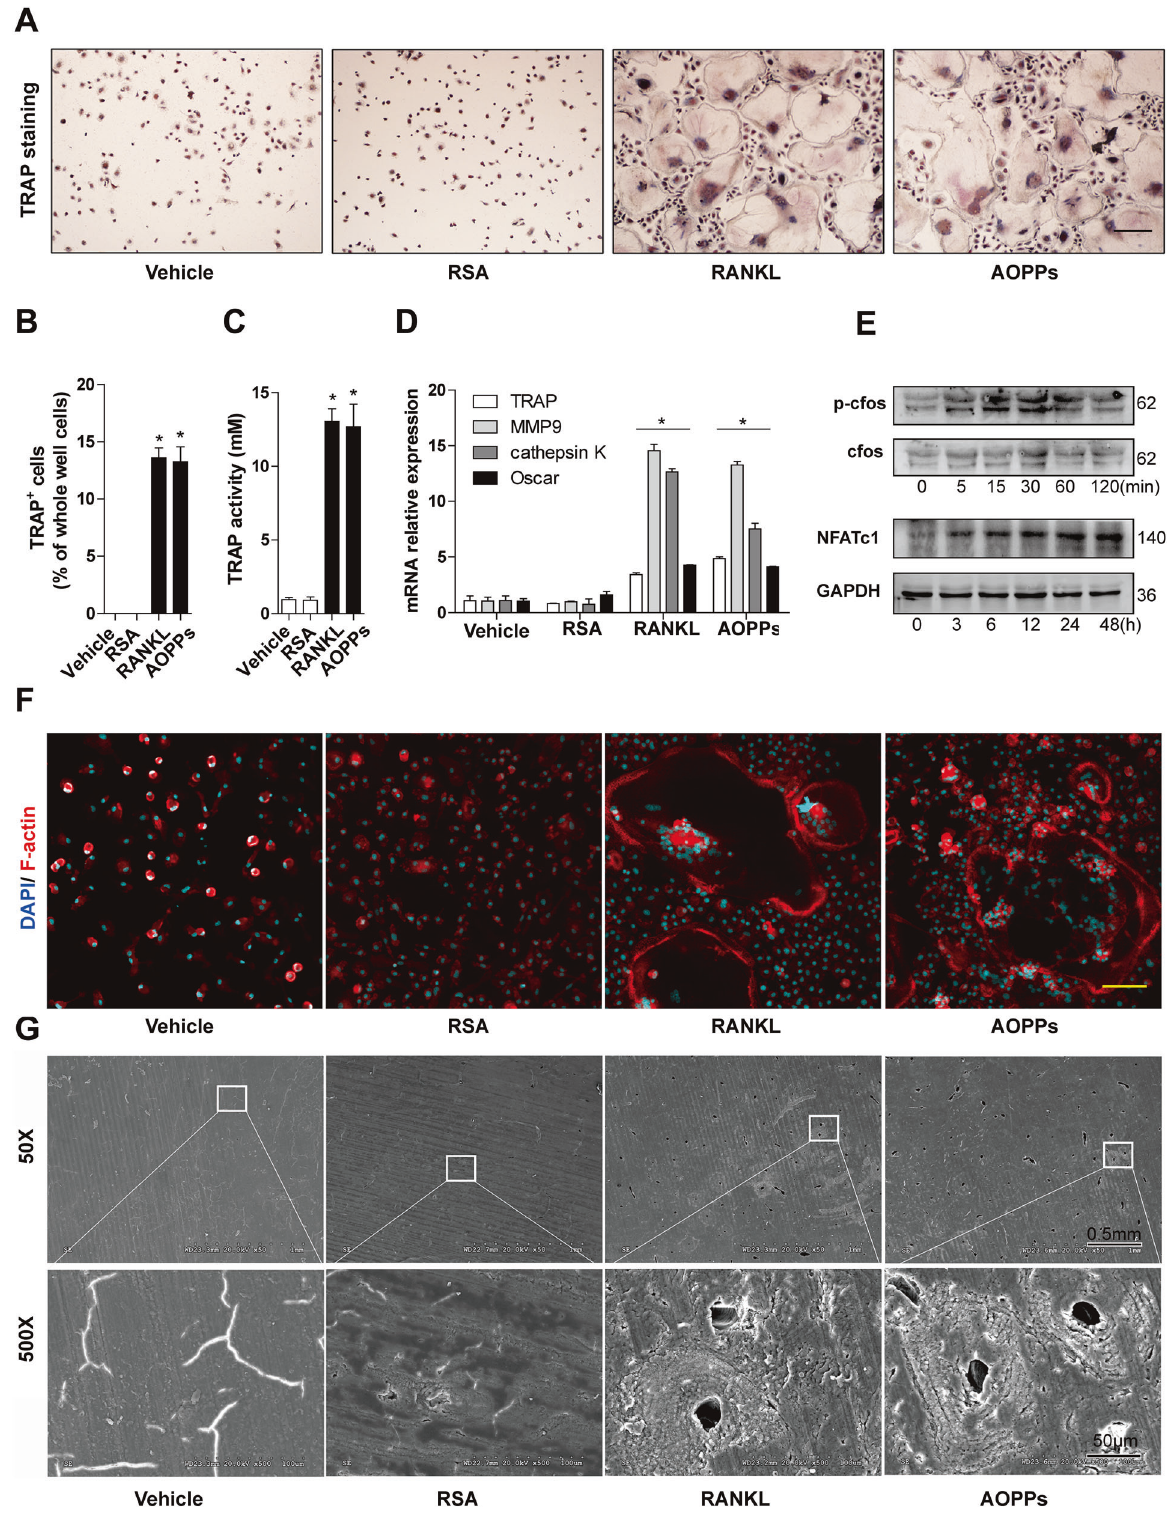
Fig. 2 AOPPs directly induced osteoclastogenesis in vitro. Rat BMMs were stimulated with or without AOPPs for 6 days, RANKL-treated cells were used as positive control, and they were not treated with MCSF. A , B AOPPs treatment induced the formation of TRAP-positive cells. Scale bar = 200 μ m. C AOPPs treatment signi fi cantly increased TRAP activity, D AOPPs treatment induced gene expression of osteoclast differentiation markers, such as TRAP, MMP9, cathepsin K and Oscar. E AOPPs treatment signi fi cantly increased the phosphorylated c-fos and expression of NFATc1. F AOPPs treatment induced the formation of F-actin ring, scale bar = 100 μ m. G Obvious resorption pits on bone slice formed in the AOPPs group and RANKL group, but not vehicle and RSA group. Data were presented as mean ± SD. * p < 0.05 versus the vehicle- treated